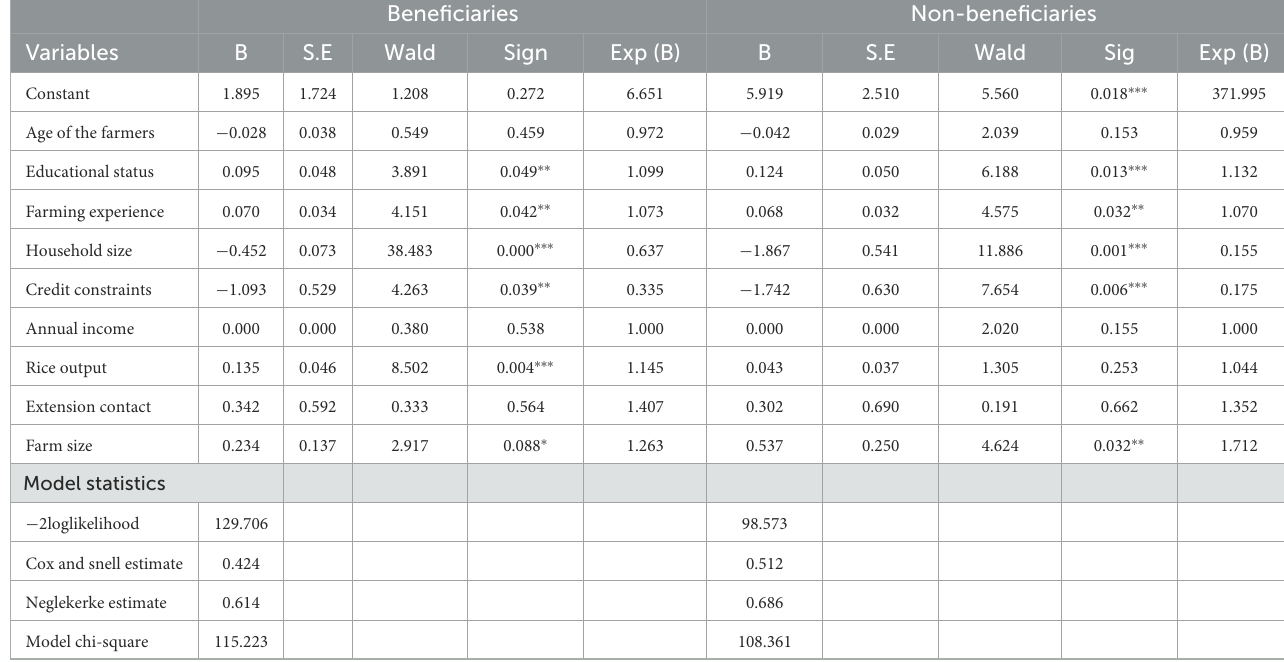
TABLE 3 Determinants of food security status of project beneficiaries and non-beneficiaries.